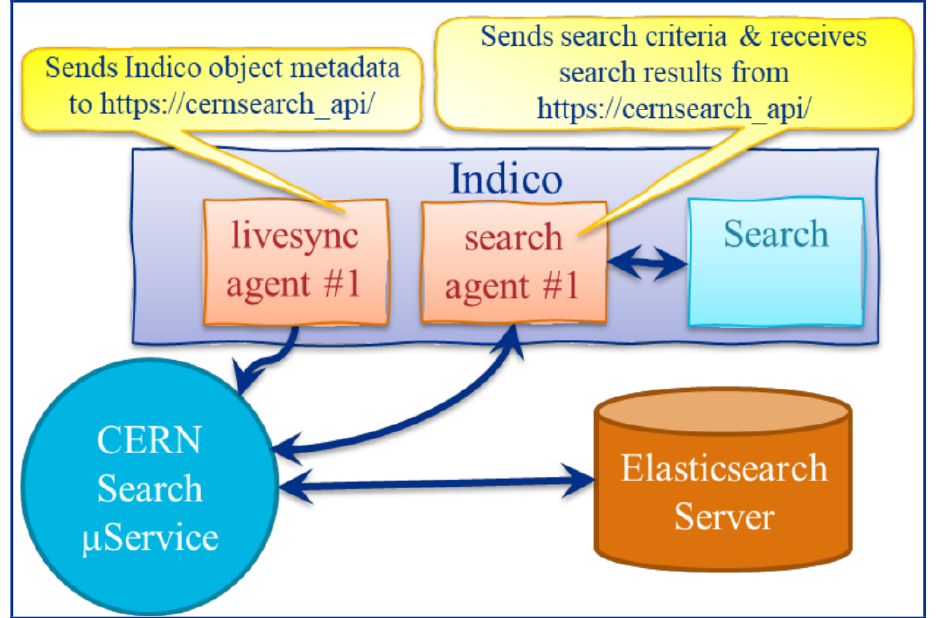
Figure 2. Indico proposed search system